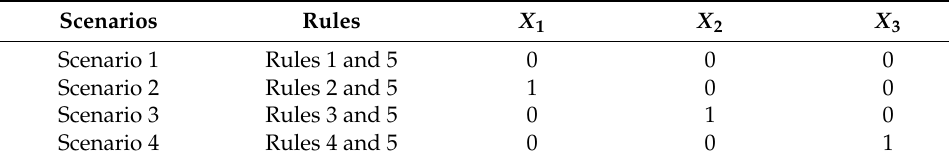
Table 2. Indicator variables used to encode the tested combination.